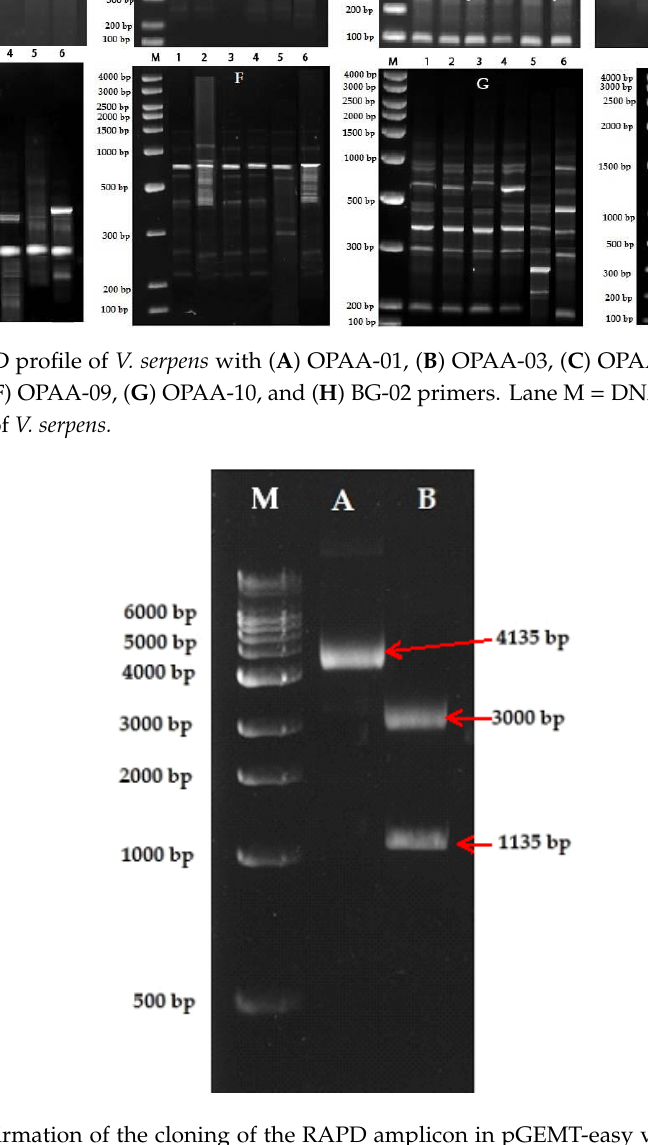
Figure 2. RAPD profile of V. serpens with ( A ) OPAA-01, ( B ) OPAA-03, ( C ) OPAA-04, ( D ) OPAA-07, ( E ) OPAA-08, ( F ) OPAA-09, ( G ) OPAA-10, and ( H ) BG-02 primers. Lane M = DNA ladder. Lanes 1–6 are accessions of V. serpens.